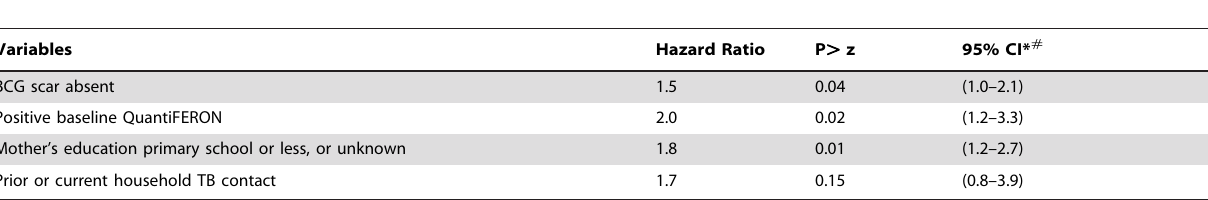
Table 5. Adjusted analyses of risk factors for bacteriologically confirmed cases of TB (N= 6,036).